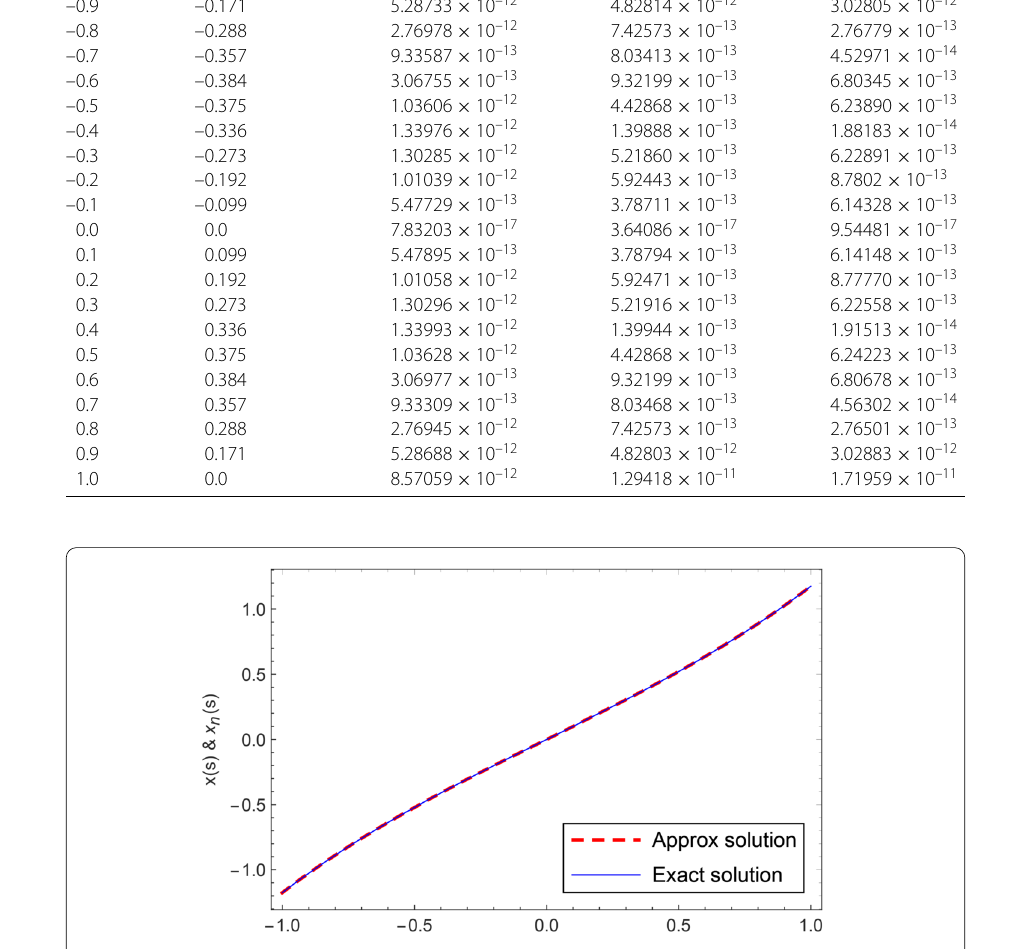
by increasing n . The exact and approximate solution are plotted in Fig. 3. The obtained absolute errors in this scheme are described in Fig. 4 and Table 2. Here, it is well seen that by increasing n , the obtained absolute error decreases and the approximate solution becomes more